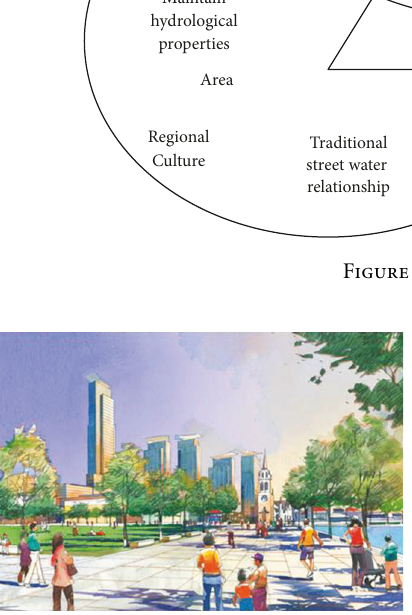
Figure 5: Schematic diagram of urban green